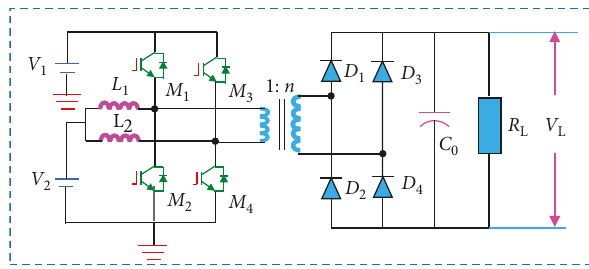
Figure 1: Conventional interleaved boost full-bridge three-port